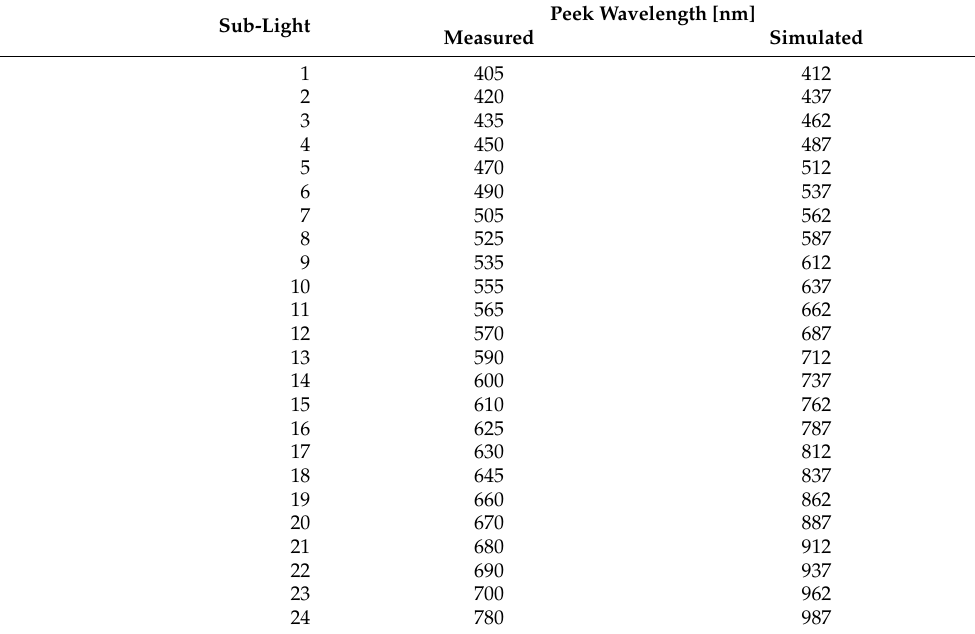
Figure 7. ( a ) The simulated sub-light source: each spectral distribution was computed by assuming a Gaussian distribution with a full-width at half maximum (FWHM) wavelength, λ FWHM = 40 nm, and its means are 412, 437, 462, 487, 512, 537, 562, 587, 612, 637, 662, 687, 712, 737, 762, 787, 812, 837, 862, 887, 912, 937, 962, and 987 nm. ( b ) The approximation of the D65 standard illumination spectral distribution with band-adjusted sub-light sources is represented in ( a ). Table 3. The specification of sub-lights.